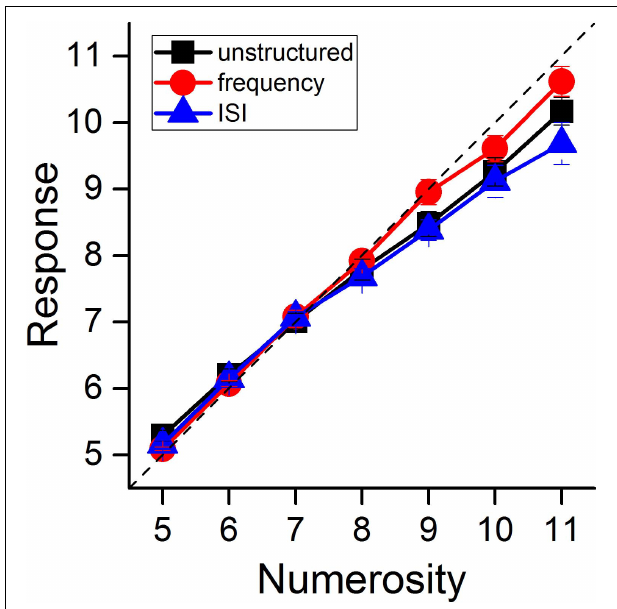
FIGURE 2 | Perceived auditory numerosity. Average perceived numerosity as a function of physical numerosity for the three experimental conditions (black squares: unstructured stimuli, red circles: stimuli grouped by frequency, blue triangles: stimuli grouped by ISI). Error bars are ± 1